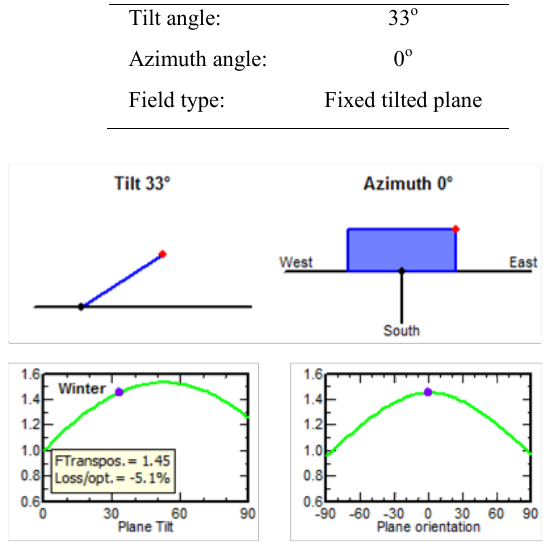
Figure 4. Tilt and azimuth angle selection in PVsyst.